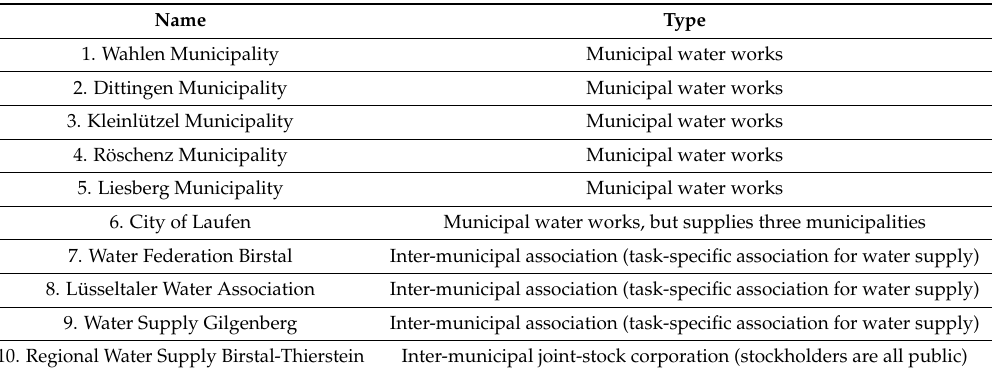
Table 1. Overview of water suppliers and types in Case 1.